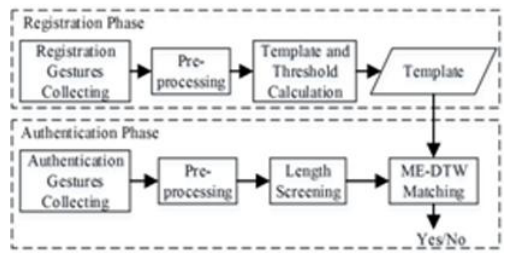
Figure 1. Flowchart of Identification Using